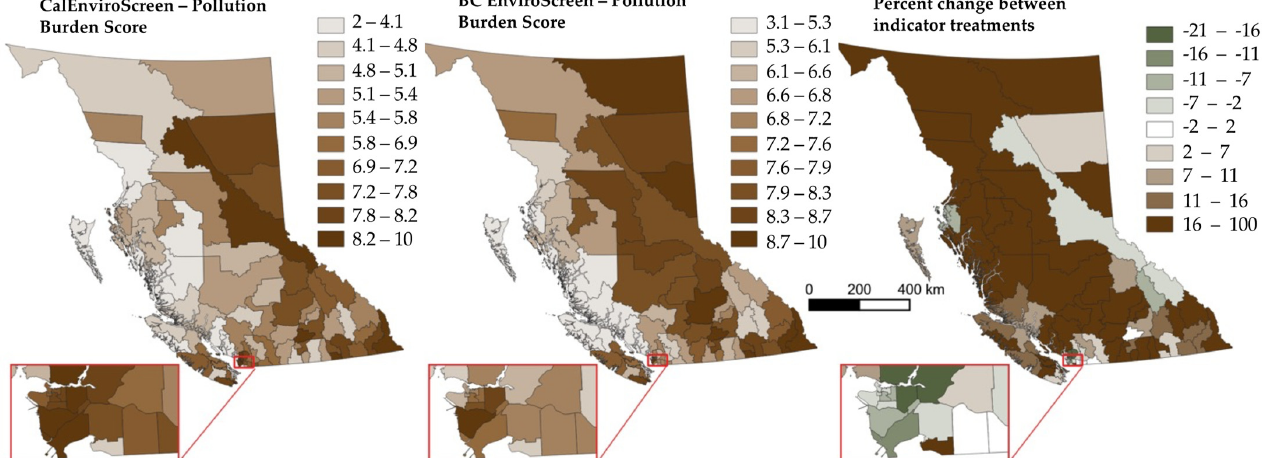
Figure 2. Comparing two treatments of EnviroScreen indicators on ‘pollution burden’ scores in British Columbia, Canada.